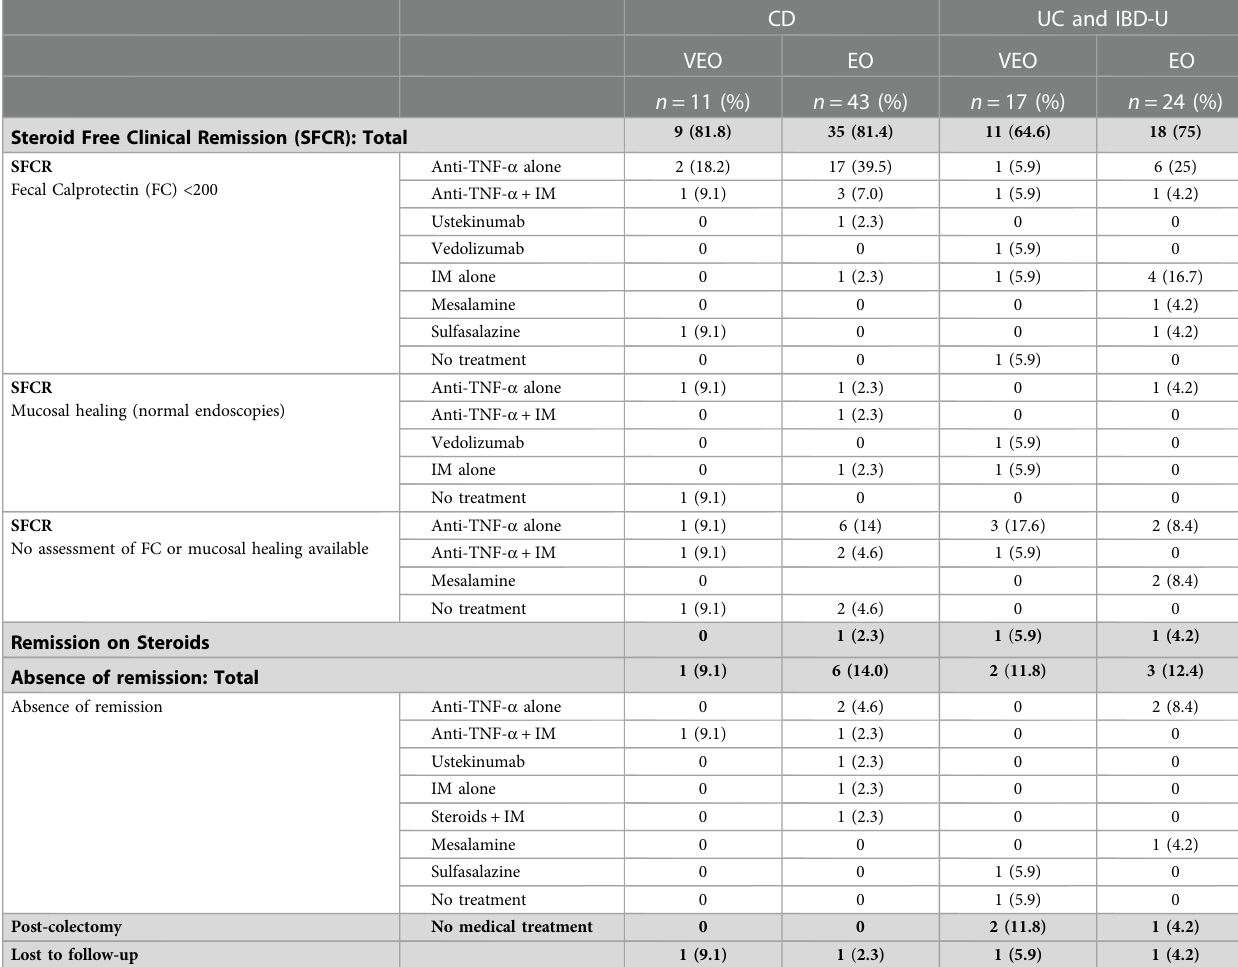
TABLE 4 Treatment and outcomes at the end of